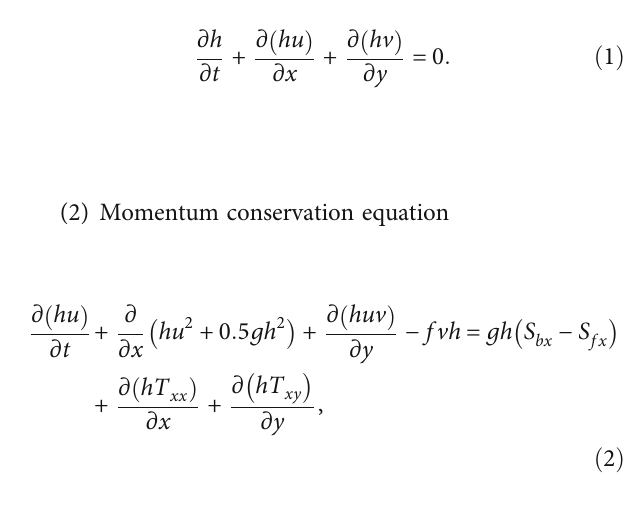
Figure 3: Encrypted grid diagram after the layout of piers in HYZ. (a) Terrain and grid of the calculated area. (b) Local high-resolution grid in Ningbo – Zhoushan Port Main Corridor and nearby waters. (c) Local grid encryption around the